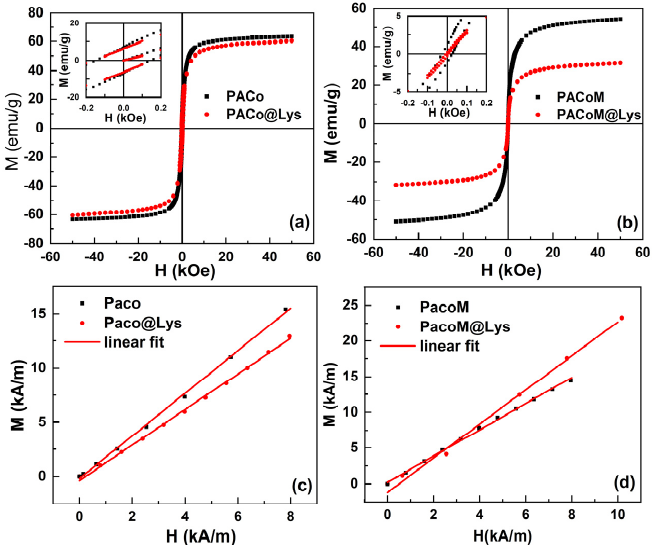
Figure 4. Field dependence of the magnetization M extracted from hysteresis loops ( a ) and ( b ). In- sets provide a magnified view of the low-field area, highlighting samples' coercivity. Low-field magnetization curve with the linear fit, ( c ) and ( d